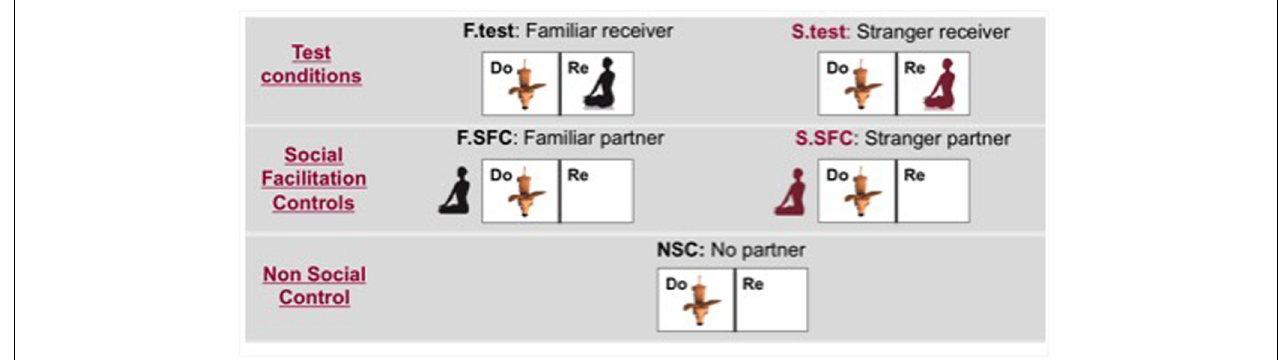
FIGURE 2 | Location of the donor-dog and human partners in each condition (Do, Donor enclosure; Re, Receiver enclosure; F .test, familiar test condition; F.SFC, Social Facilitation Control with the familiar human; S .test, Stranger test condition; S.SFC, Social Facilitation Control with the familiar human; NSC, Non Social